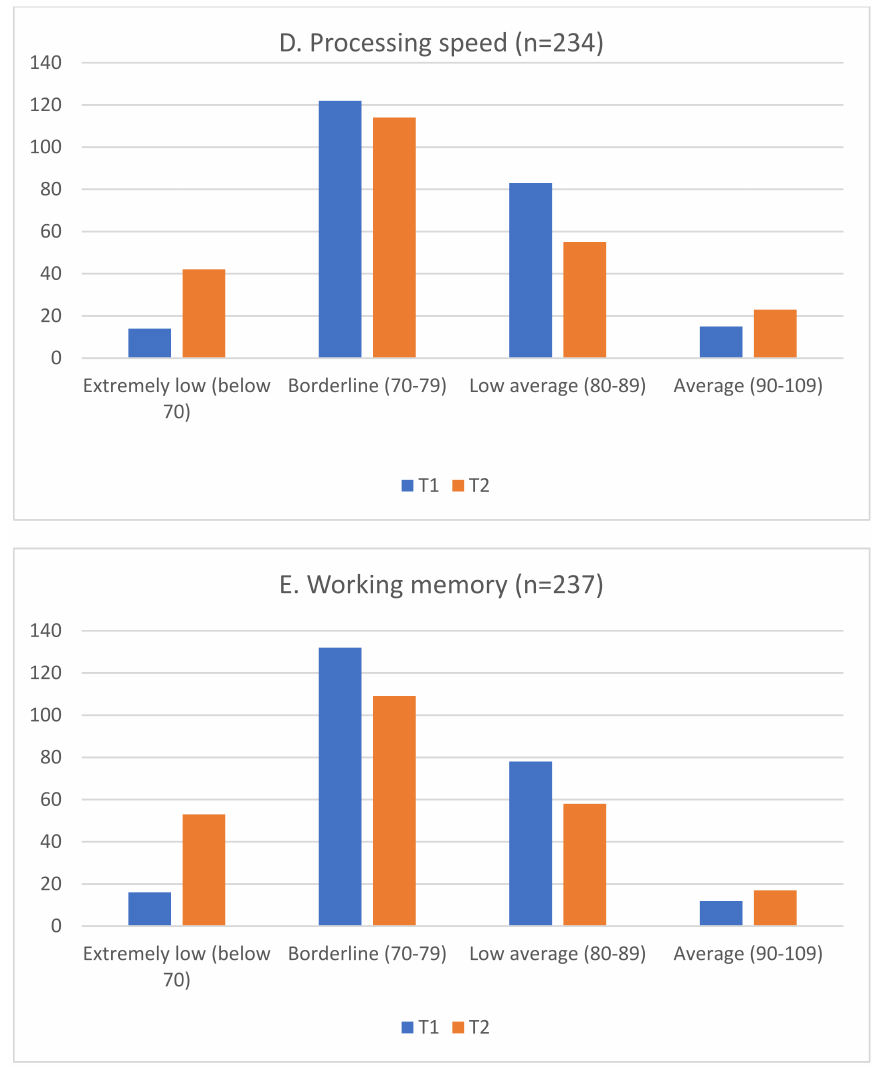
Figure 1. ( A – E ) Change in frequencies in total cognition, verbal and visual performance, processing speed, and working memory in the first (T1) and last (T2) neuropsychological assessments. Table 3. The proportion of participants having major difficulties (frequency and percentage) in the assessed NEPSY-II neuropsychological subdomains, and conduct, self-esteem, and activities of daily living compared between assessment 1 (T1) and 2 (T2). The number of patients with data on both assessments within the given subdomain is shown in “ n